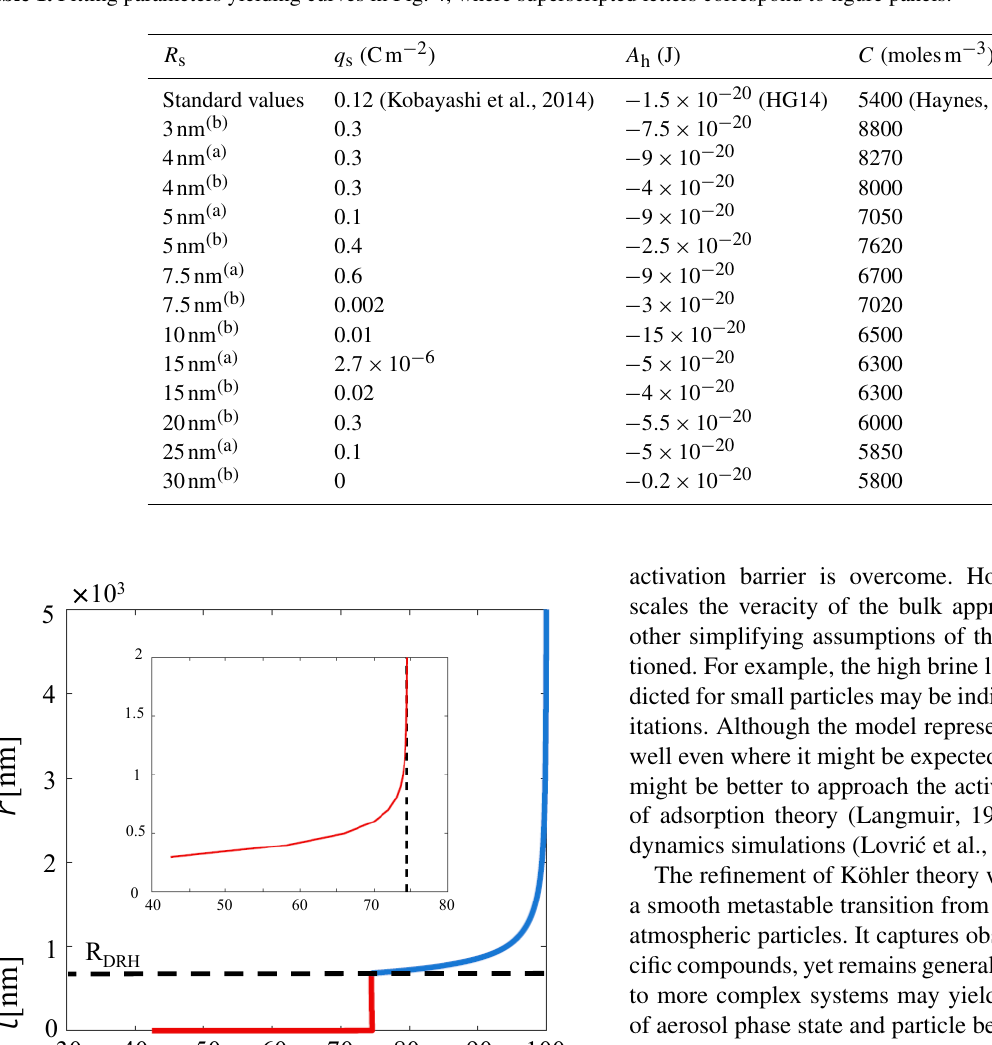
Table 1. Fitting parameters yielding curves in Fig. 4, where superscripted letters correspond to figure panels.